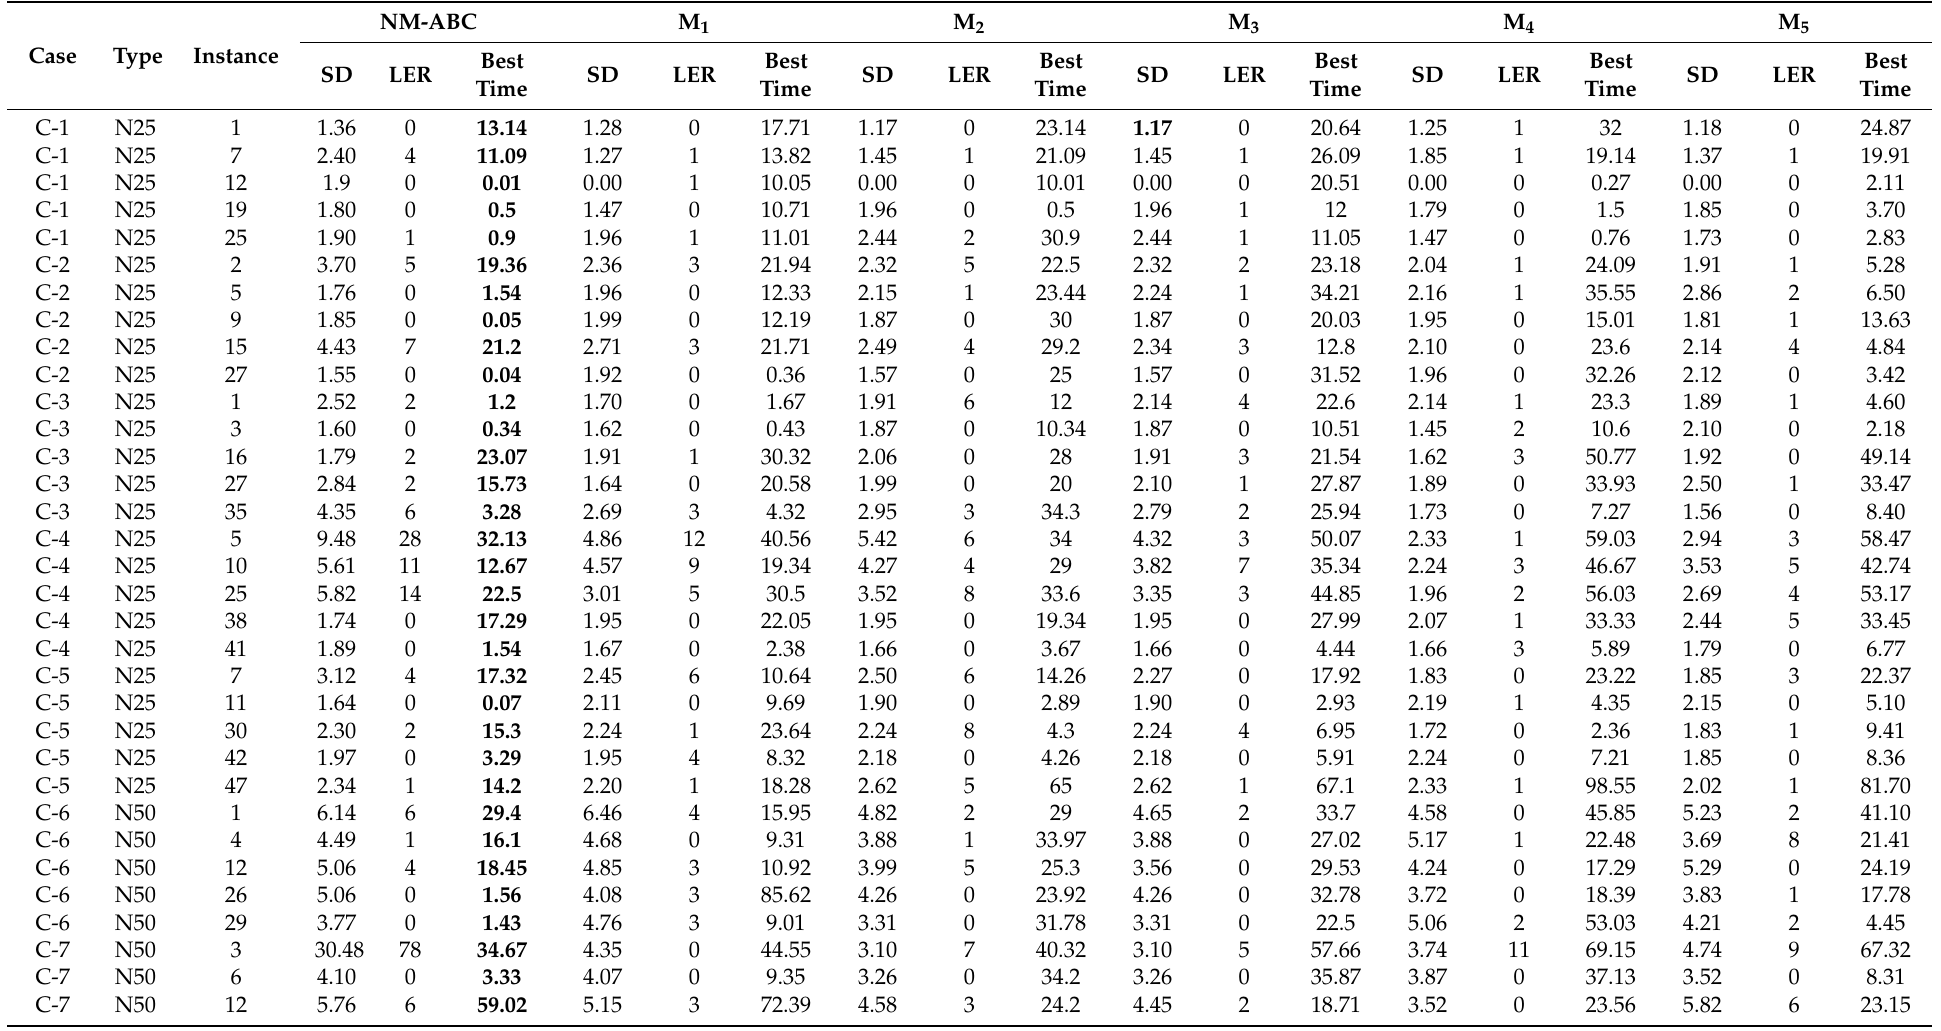
Table 4. Summary of standard deviation, least error, and best time obtained by proposed Artificial bee colony with Nelder Mead method (NM-ABC) and competitor